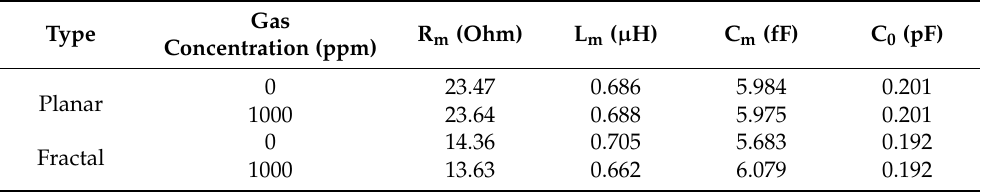
Table 5. Equivalent circuit parameters for PIB-coated